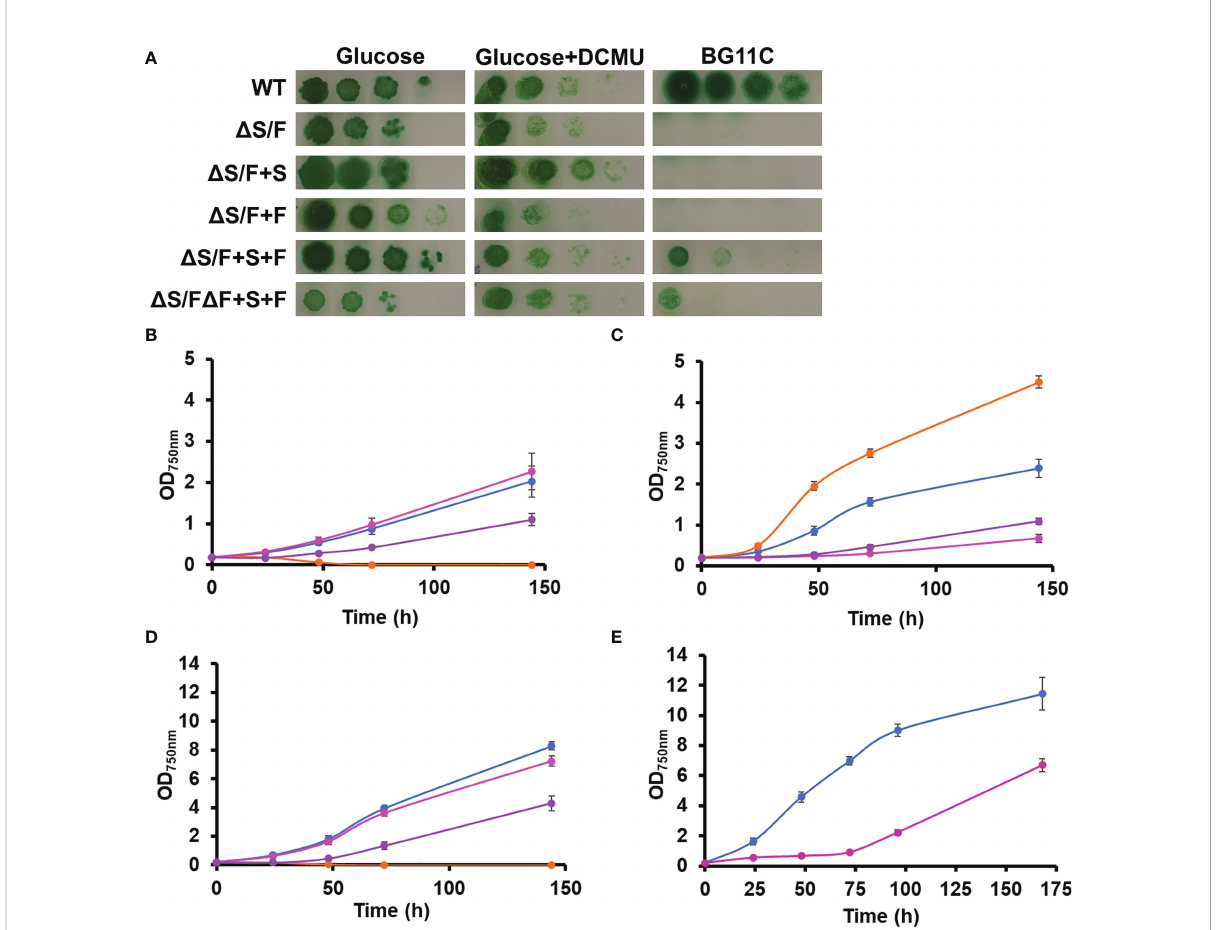
FIGURE 3 Complementation of D S/F mutant strain with FBPase and SBPase plant genes. (A) Growth of WT, D S/F, D S/F+S, D S/F+F, D S/F+S+F, and D S/F D F+S+F in different trophic regimes. Cultures were grown in BG11C supplemented with 10 mM glucose light until the exponential phase washed twice with BG11C, and 10-fold serial dilutions of a suspension of 1 µg chlorophyll ml − 1 cells were spotted onto BG11C, BG11C supplemented with 10 mM glucose, or BG11C supplemented with 10 mM glucose and 20 µM DCMU. Plates were incubated at 5 µmol photon m − 2 s − 1 and photographed after 10 days of growth. (B) Photomixotrophic growth of WT, D S/F, D S/F+S, D S/F+F, D S/F+S+F, and D S/F D F+S+F in liquid media. WT ( ○ ), D S/F ( ○ ), D S/F+S +F ( ○ ), and D S/F D F+S+F ( ○ ) were grown in BG11C + 10 mM glucose in low light until the exponential phase. Cells were washed twice in BG11C and inoculated in BG11C supplemented with 10 mM glucose at OD 750nm 0.2 bubbled with 1% CO 2 -enriched air at 5 µmol photon m − 2 s − 1 . Growth was monitored by measuring OD 750nm . Data represented are the mean and standard error of three to four (depending on the time point) biological independent cultures. (C) Photoautotrophic growth of WT, D S/F, D S/F+S, D S/F+F, D S/F+S+F, and D S/F D F+S+F in liquid media. WT ( ○ ), D S/F ( ○ ), D S/F +S+F ( ○ ), and D S/F D F+S+F ( ○ ) were grown in BG11C in low light until the exponential phase. Cells were washed twice in BG11C and inoculated in BG11C at OD 750nm 0.2 bubbled with 1% CO 2 -enriched air at 5 µmol photon m − 2 s − 1 . Data represented are the mean and standard error of three to four (depending on the time point) biological independent cultures. (D) Photoautotrophic growth of WT, D S/F, D S/F+S, D S/F+F, D S/F+S+F, and D S/ F D F+S+F in liquid media. Conditions were the same as in (C) except for the light that was 50 µmol photon m − 2 s − 1 . Data represented are the mean and standard error of three to four (depending on the time point) biological independent cultures. (E) Photoautotrophic growth of WT and D S/F+S +F in liquid media. WT ( ○ ) and D S/F+S+F ( ○ ) were grown in BG11C in low light until the exponential phase. Cells were washed twice in BG11C and inoculated in BG11C glucose at OD 750nm 0.2, bubbled with 1% CO 2 -enriched air at 185 µmol photon m − 2 s − 1 . Data represented are the mean and standard error of three to four (depending on the time point) biological independent